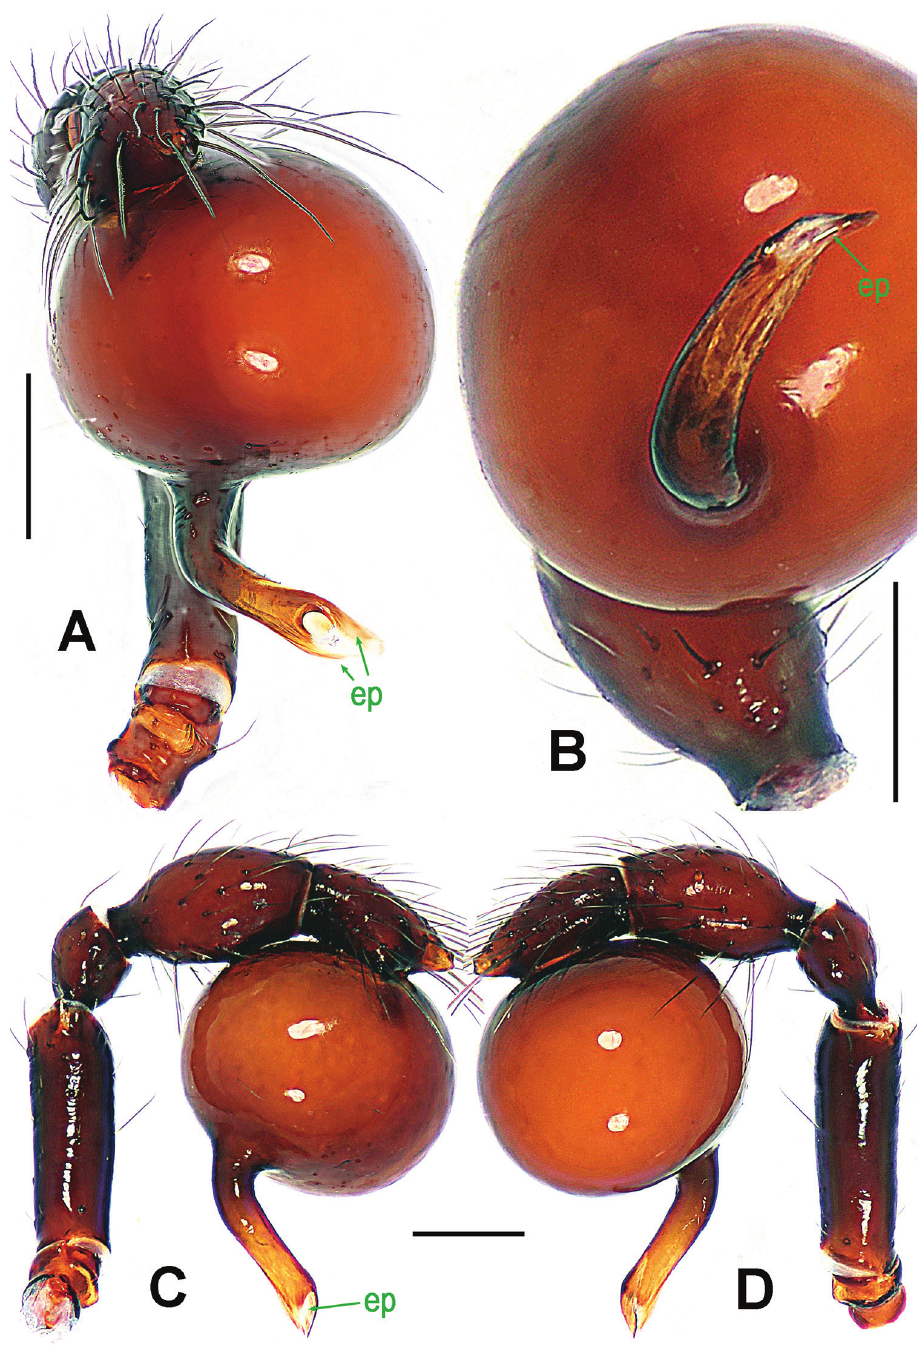
Figure 5. Paculla globosa sp. n., male holotype. A, C–D left palp B palpal bulb. A anterior B ventral C prolateral D retrolateral. Abbreviations: ep = embolic part of apes of palpal organ. Scale bars: 0.20